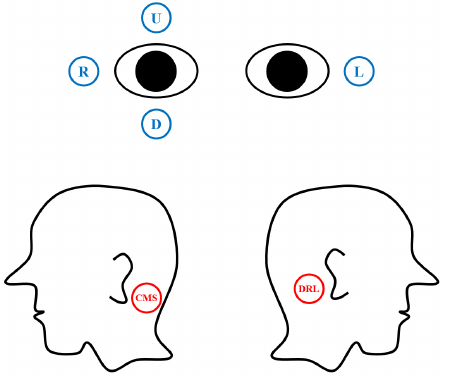
Figure 1. Electrode placements used to record the horizontal and vertical EOG